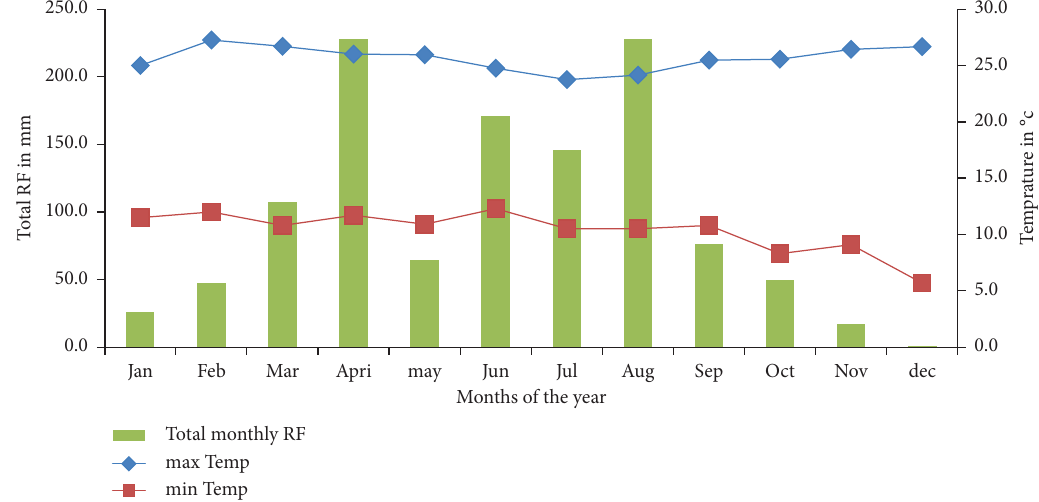
Figure 2: Monthly mean annual rainfall and monthly minimum and maximum temperature of Meskan District. Table 1: Physicochemical properties of the study site’s soil before